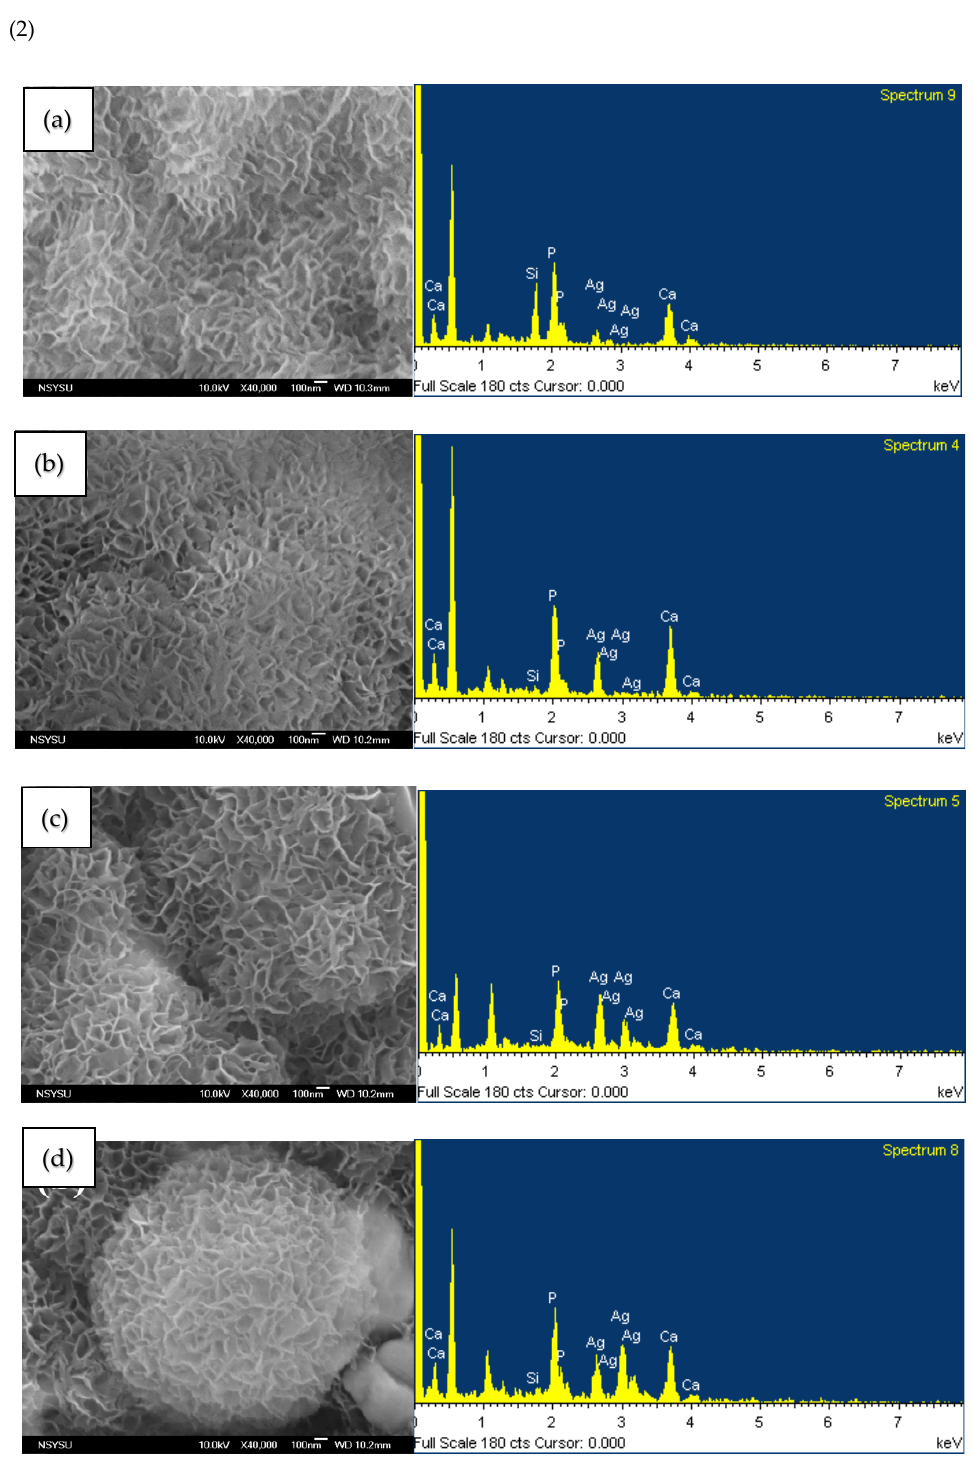
Figure 7. ( 1 ) SEM images and EDS results of (a) MBG–coated Ti, (b) MBG–Ag1–coated Ti, (c) MBG– Ag5–coated Ti, and (d) MBG–Ag10–coated Ti. ( 2 ) SEM images and EDS results of (a) MBG–coated Ti, (b) MBG–Ag1–coated Ti, (c) MBG–Ag5–coated Ti, and (d) MBG–Ag10–coated Ti after immersion